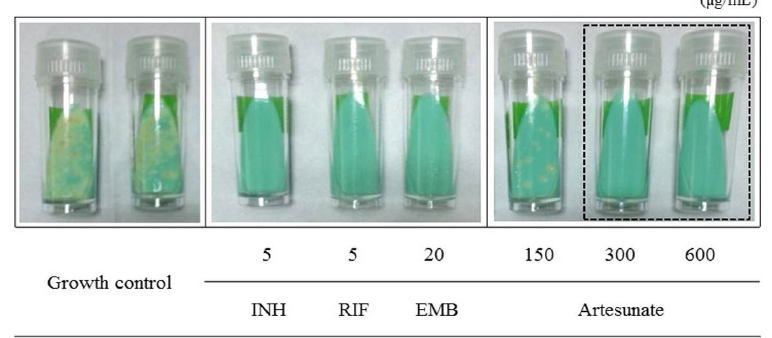
Figure 4. The anti-Mtb effect of artesunate against the growth/proliferation of Mtb confirmed using the Ogawa slant assay. Mtb was incubated with different concentrations (150–600 µ g/mL) of artesunate on 2% Ogawa slant medium, respectively. Bacterial growth colonies were observed after three weeks of incubation. The dotted line indicates the anti-Mtb activity/effects of artesunate against Mtb. (INH; isoniazid, RIF; rifampicin, EMB; ethambutol). The Ogawa slant medium assay was carried out three times